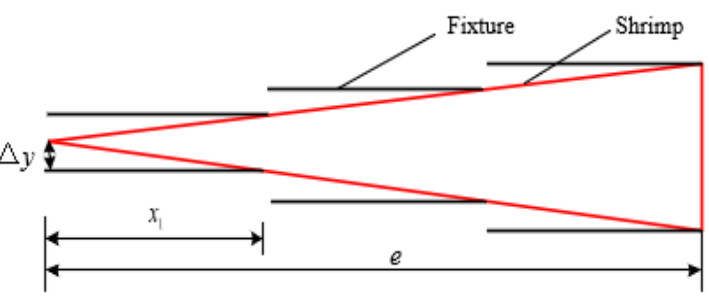
Figure 4. Segmented clamping.